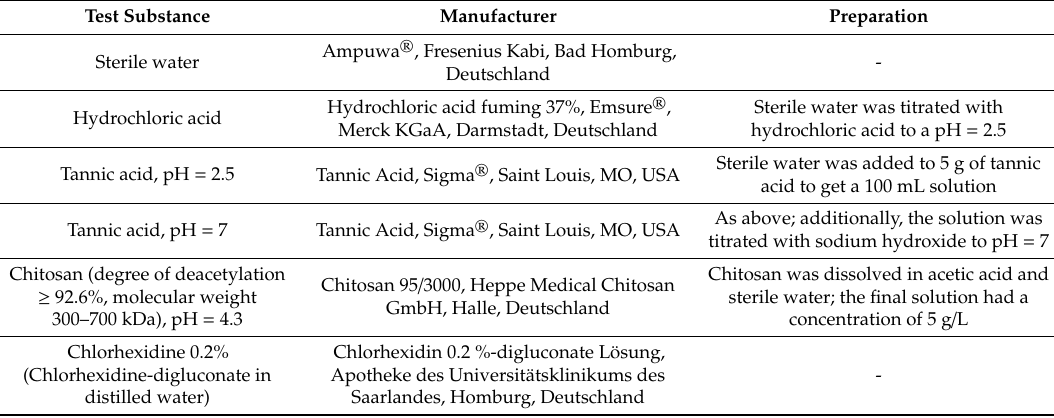
Figure 2. Rinsing sequences every subject has to go through. In each round, one test substance was applied according to one rinsing protocol.